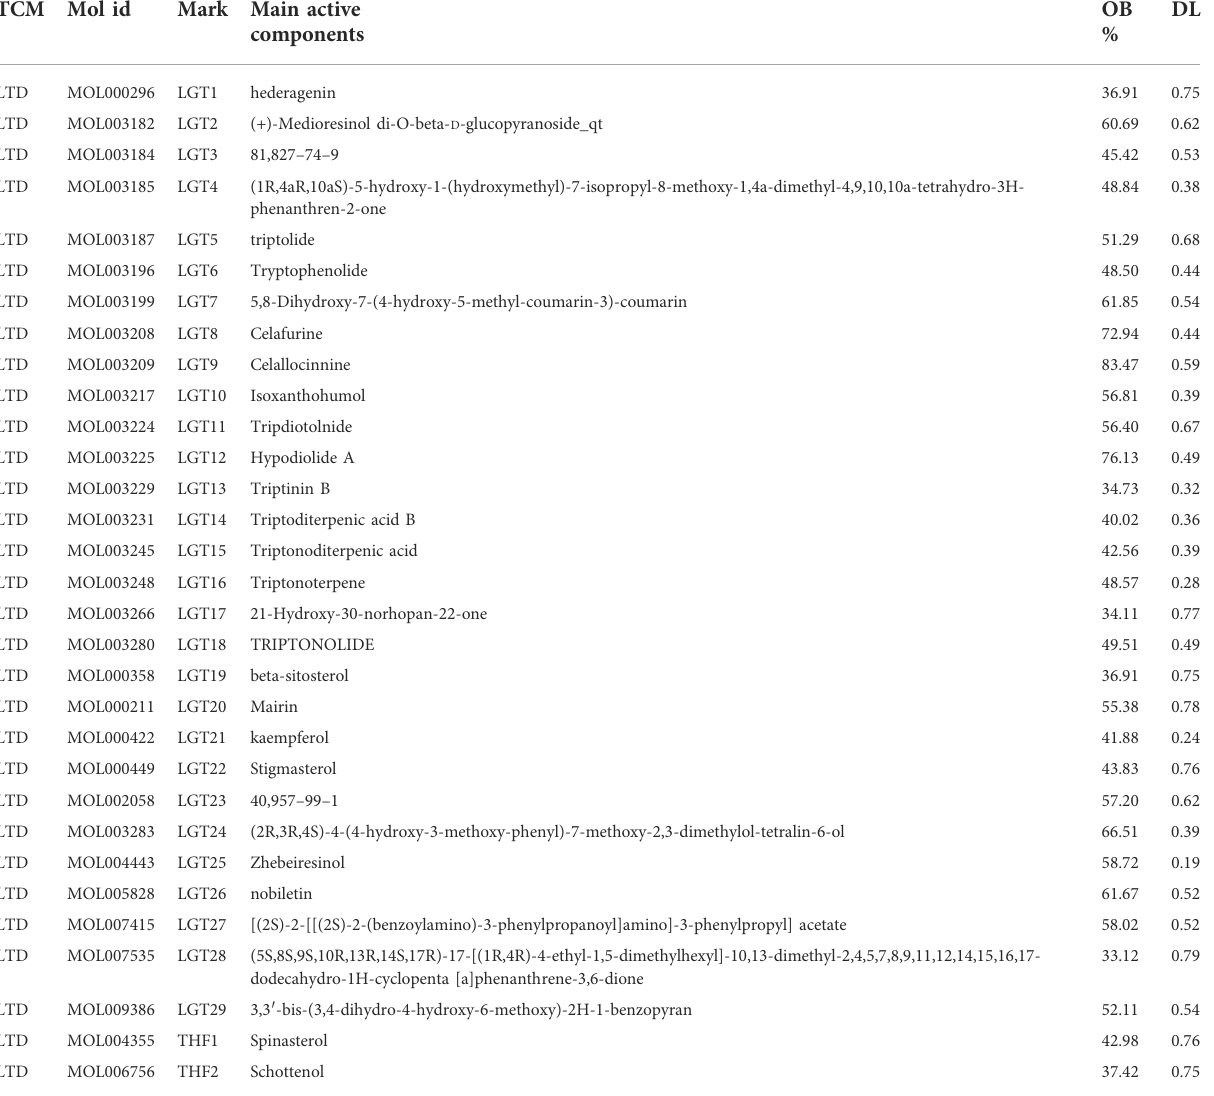
TABLE 1 Key active components of